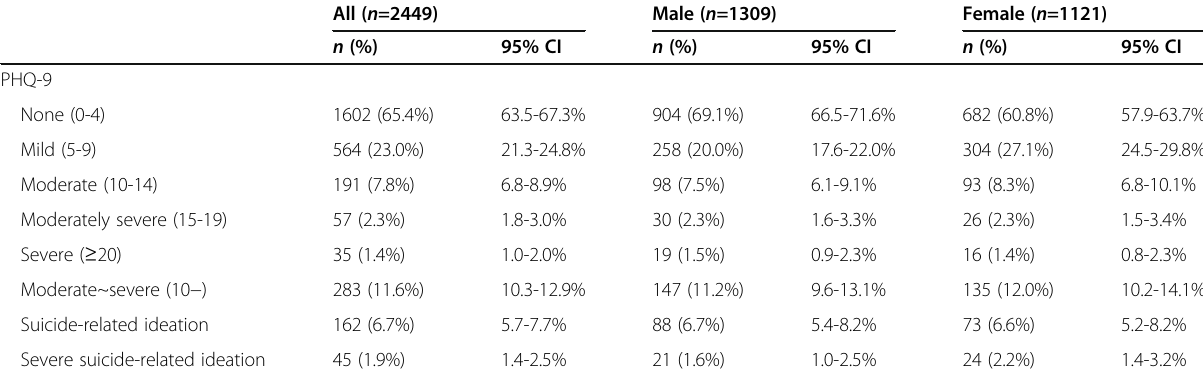
Table 2 Prevalence of depressive symptoms and suicide related ideation All ( n